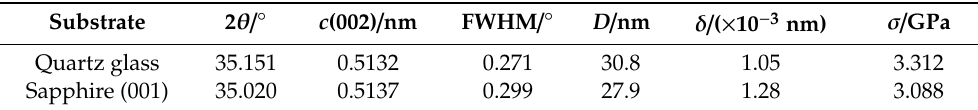
Table 1. Peak position (2 θ ), lattice constant ( c ), full width at half maximum (FWHM), calculated grain size ( D ), dislocation density ( δ ), and stress values ( σ ) of the as-received ZnO thin films grown on the quartz glass and sapphire (001) substrates with an annealing treatment of 600 ◦ C for 1